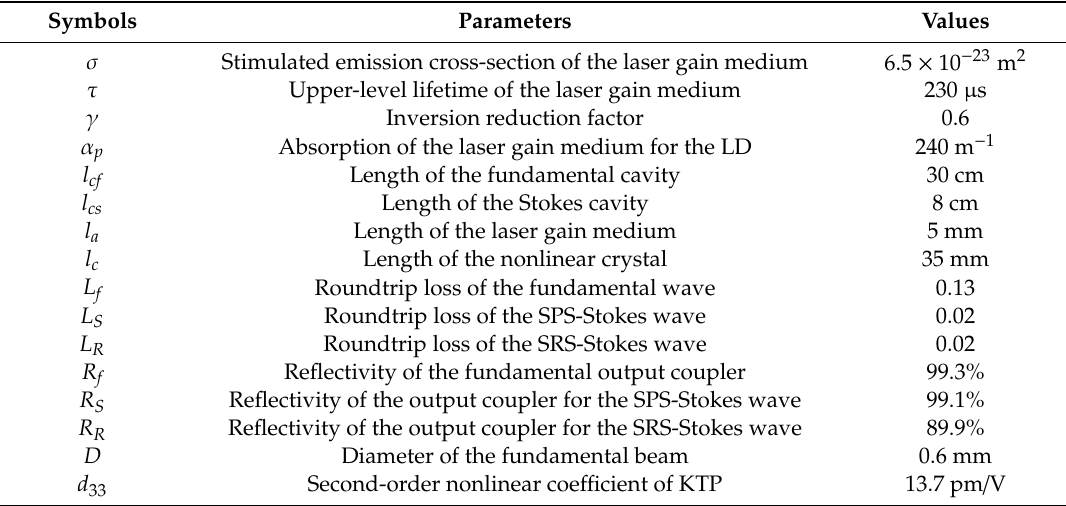
Figure 6. Gain coefficient G S as a function of the polariton wave number, and the SPS effect permitted areas are roughly marked by grey rectangles. Table 2. Parameters in the rate equations. LD: laser diode; SPS: stimulated polariton scattering; SRS: stimulated Raman scattering.